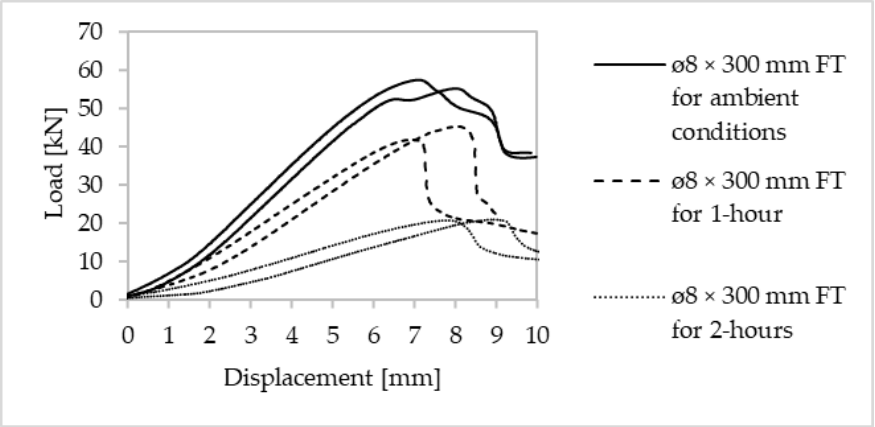
Figure 12. Load-displacement plots of Ø 8 × 300 mm ASSY VG CSK (FT) connections at 45